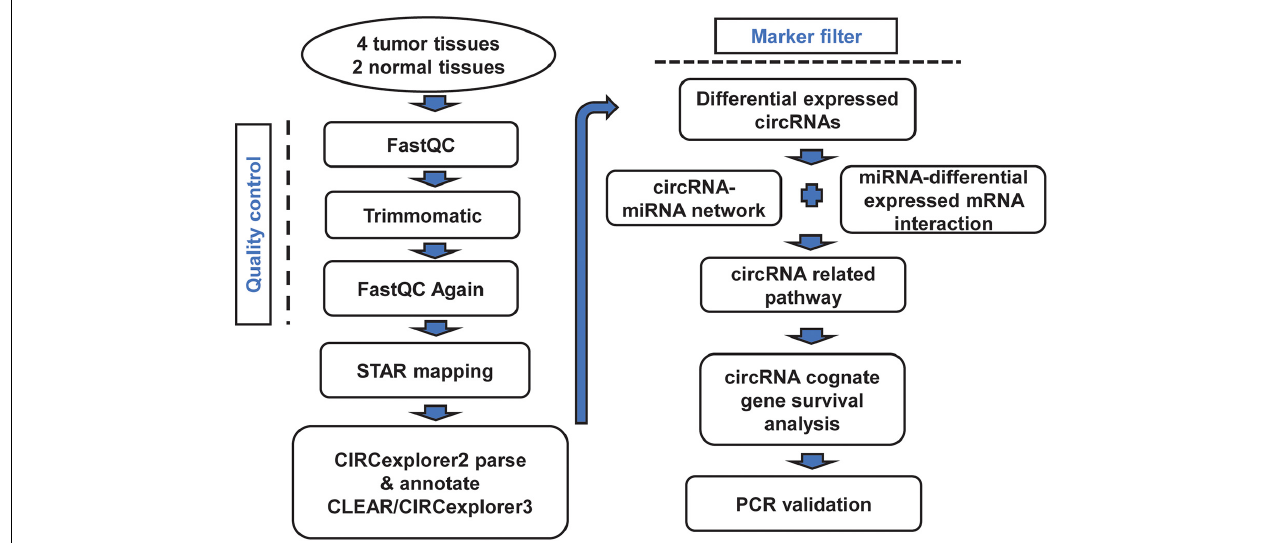
FIGURE 1 | Bioinformatics analysis pipeline of our